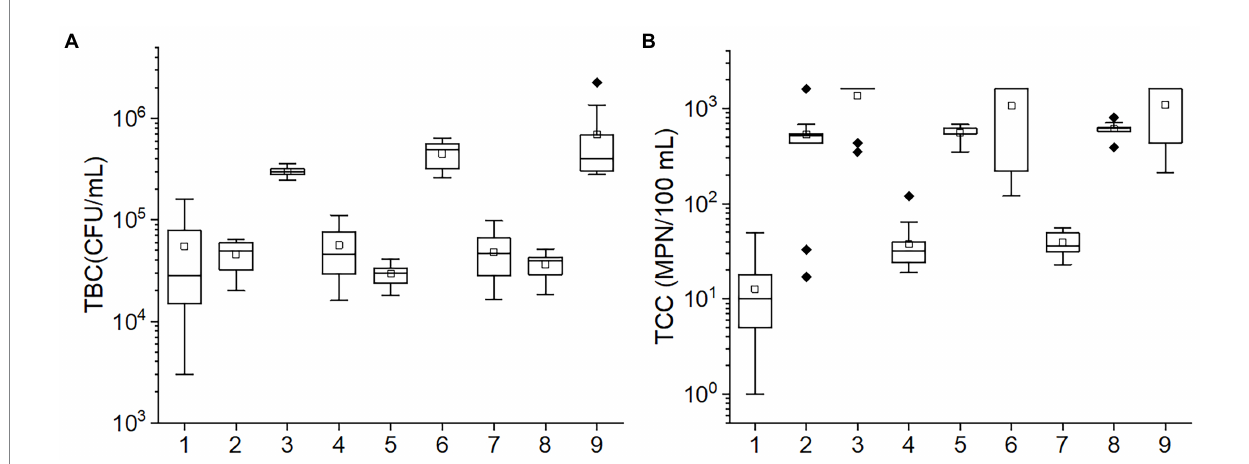
FIGURE 2 The box plots of the (A) TBC and (B) TCC concentrations in various conditions in the orthogonal experiment. The numbers in the horizontal axis stand for different conditions: 1: 10 ° C, pH = 6, porosity = 0.50; 2: 20 ° C, pH = 8, porosity = 0.50; 3: 30 ° C, pH = 7, porosity = 0.50; 4: 10 ° C, pH = 7, porosity = 0.55; 5: